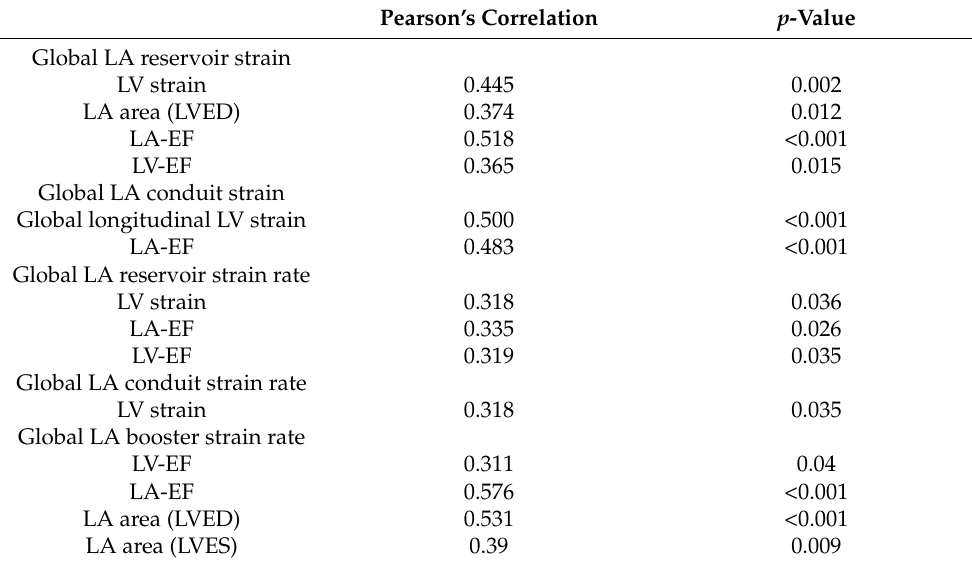
Table 6. Pearson’s correlation for left atrial reservoir strain and other disease-relevant factors in cardiac